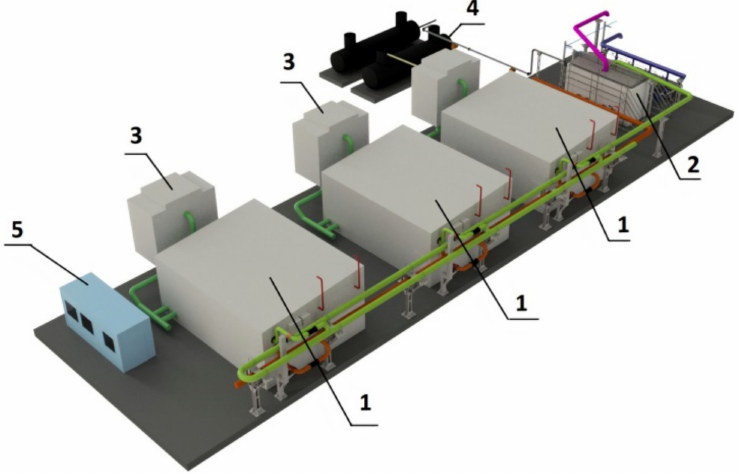
Figure 5. Model of the primary system of freezing installation: 1—cooling aggregates, 2—brine tank, 3—cooling towers, 4—discharge tank, 5—water treatment